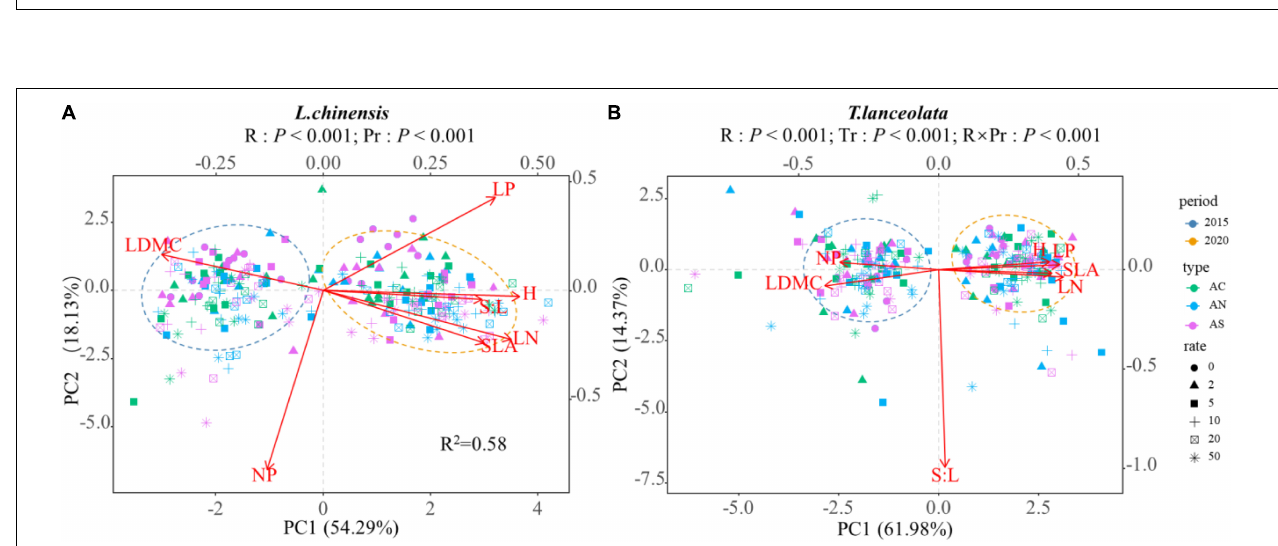
FIGURE 8 | Principal components analysis (PCA) for all leaf functional traits of two species across different N addition rates and different periods: (A) Leymus chinensis ; (B) Thermopsis lanceolata . The length of a variable vector in the representation space is indicative of the variable’s level of contribution. Different shapes represent different nitrogen addition rates, and different colors represent different N compound type. The two ovals are the distribution ranges of plant traits in two periods respectively.